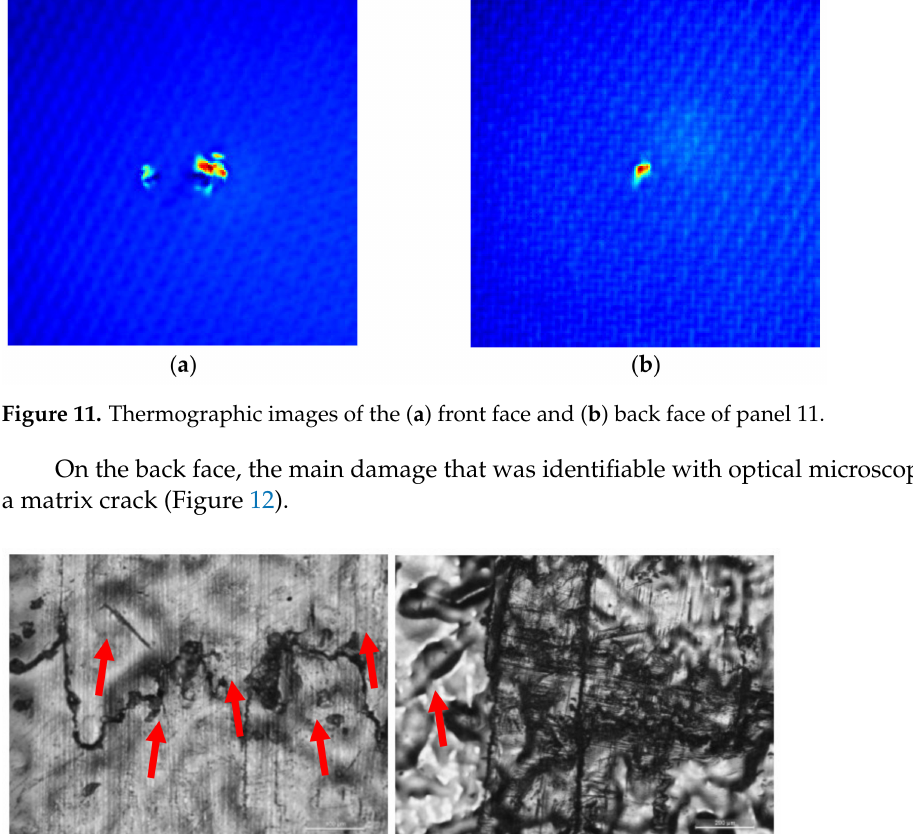
Figure 12. Microscopic images of the back face of panel 11 with a matrix crack ( left ) and localised damage ( right ).